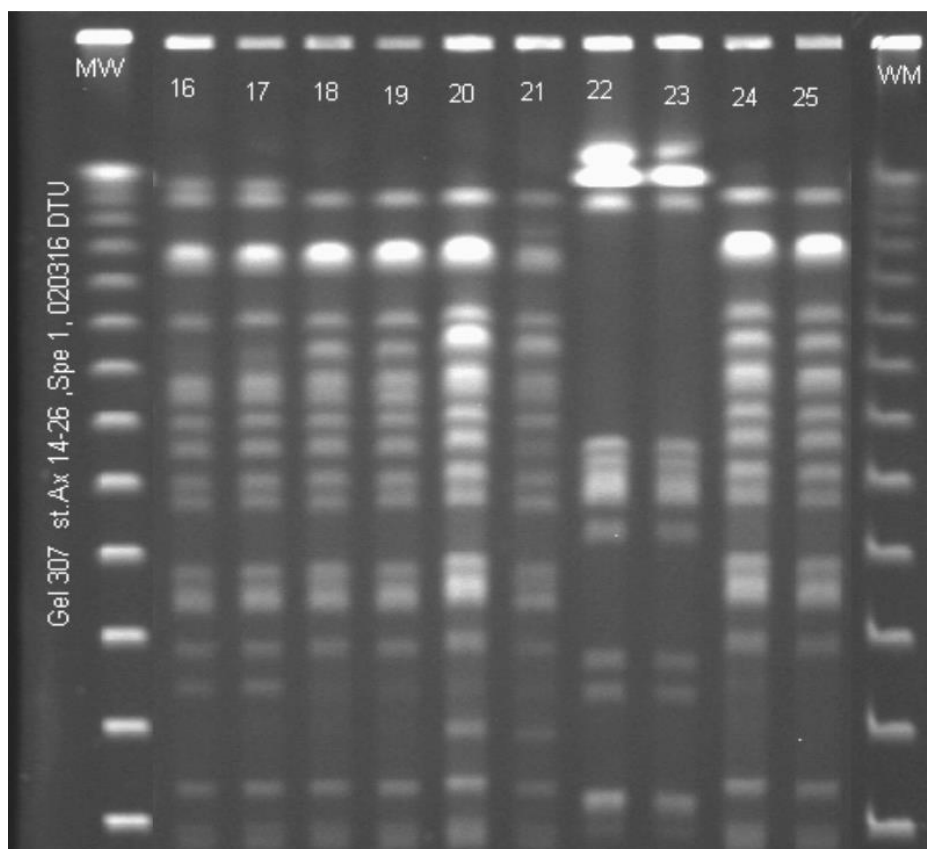
Figure 3. Pulsed-field-gel-electrophoresis pattern of 10 paired Achromobacter xylosoxidans isolates from bronchoalveolar lavage (BAL) fluid from five cystic fibrosis (CF) patients before and after lung transplantation (ltx). The Spe restriction enzyme was used. MW: molecular-weight standard. Lane 16 and 17: CF334 ML, before (lane16) and after ltx (lane 17). Lane 18 and 19: CF340 JP, before (lane 18) and after ltx (lane 19). Lane 20 and 21: CF353 ST, before (lane 20) and after ltx (lane 21). Lane 22 and 23: CF172 TN, before (lane 22) and after ltx (lane 23). Lane 24 and 25: CF347 HM, before (lane 24) and after ltx (lane 25).